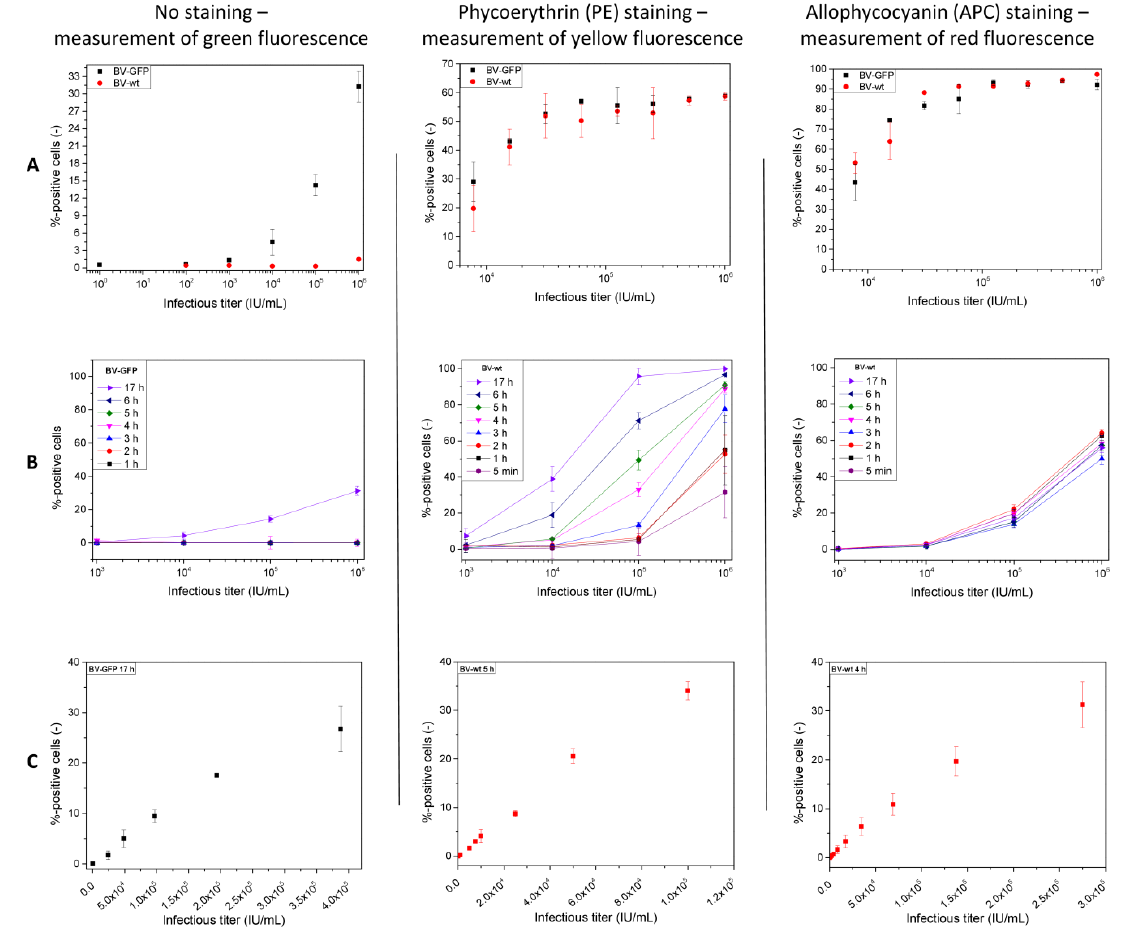
Figure 3. Development of the flow cytometric quantification protocol for baculoviruses (either wild- type or virus expressing the green fluorescent protein, BV-wt and BV-GFP, respectively). In a first approach, ( A ) the detection capability for both viruses was determined without further method optimization after 18 h of cell infection and subsequent flow cytometric detection of fluorescent cells. Depending on the staining procedure, green (no staining, left column), yellow (PE staining, middle column), or red fluorescence (APC staining, right column) was evaluated. The infection kinetics of the three approaches ( B ) indicate the earliest possible time of quantification at which the linear calibration range was subsequently determined for each individually optimized strategy ( C ). Error bars depict standard deviation of technical triplicates ( A , B ) and 18 replicates with n = 6 on three different days for ( C